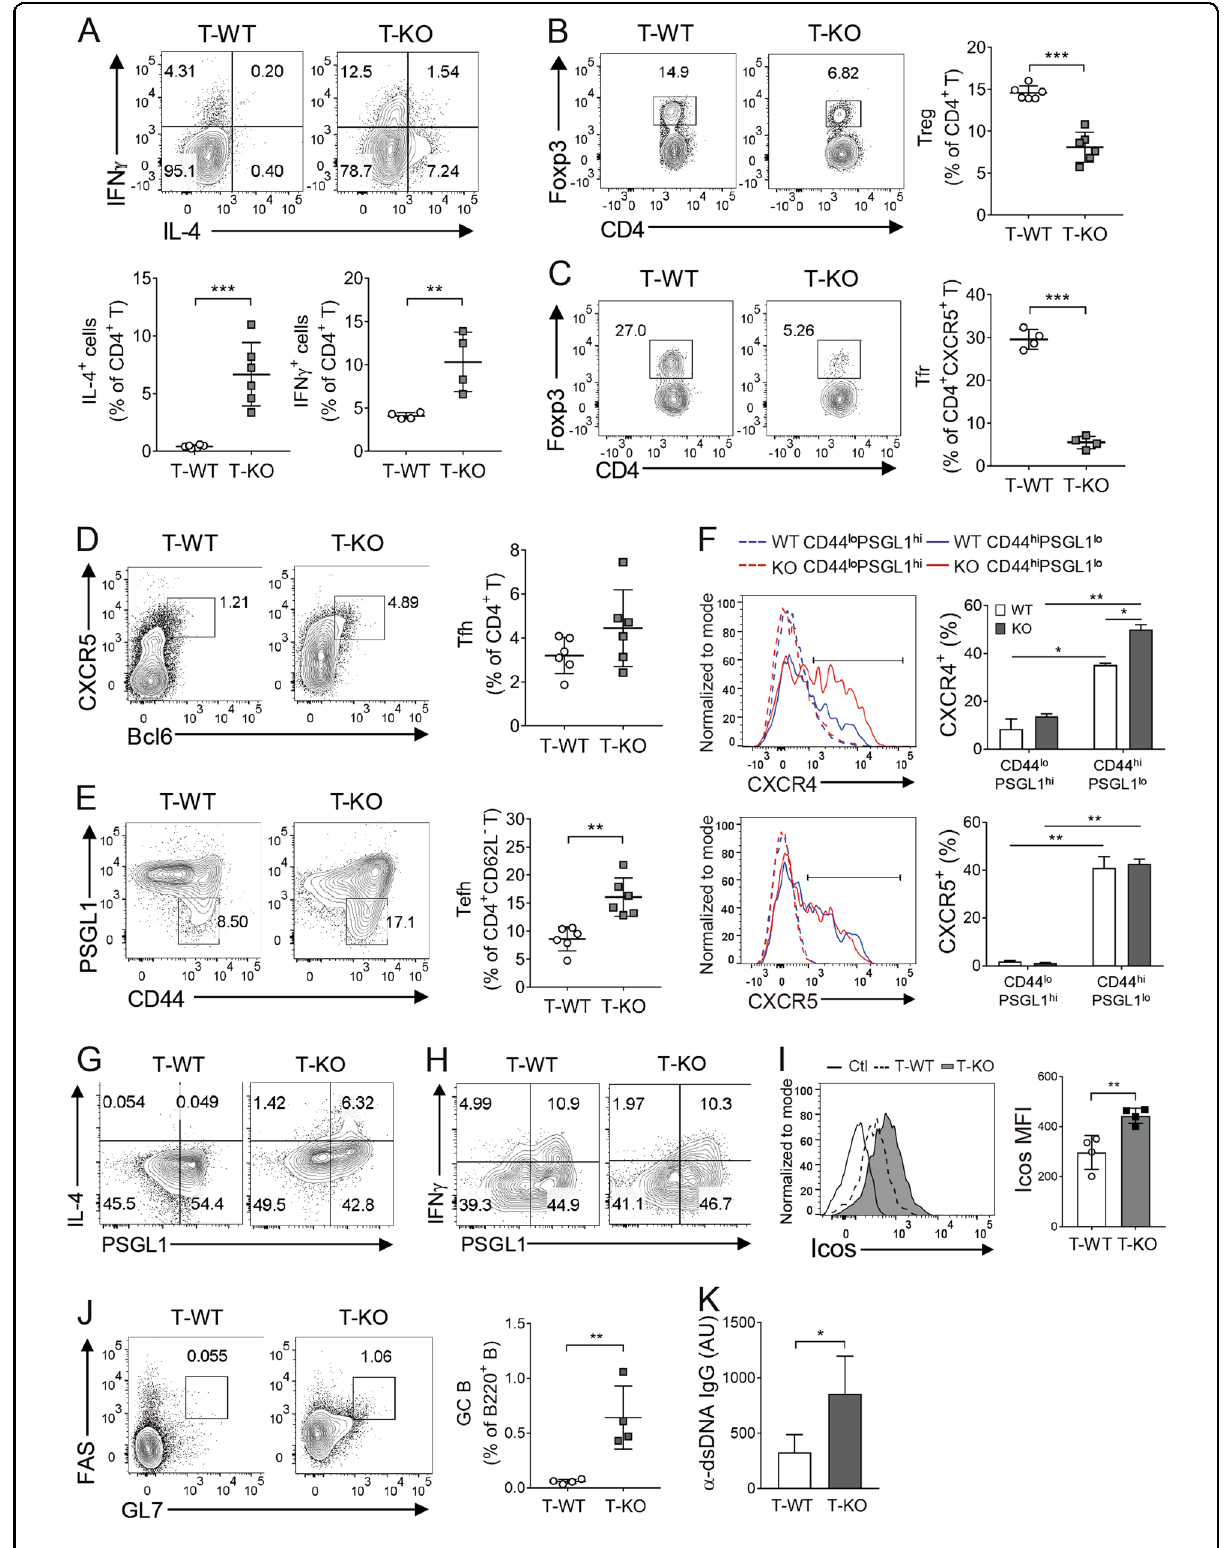
Fig. 5 (See legend on next